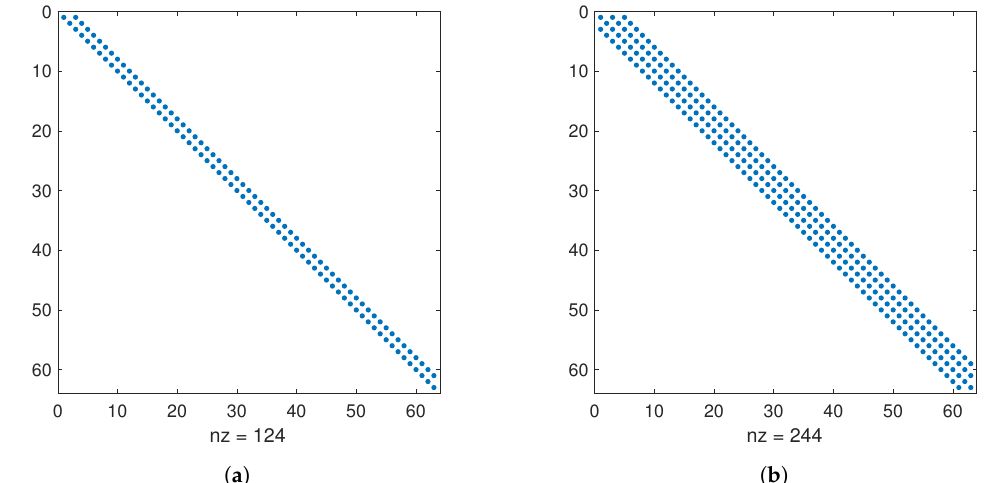
Figure 1. Non-zero elements of the matrices ˜A x and ˜C x are presented in ( a ) and ( b ), respectively. Here, both L and M are set to